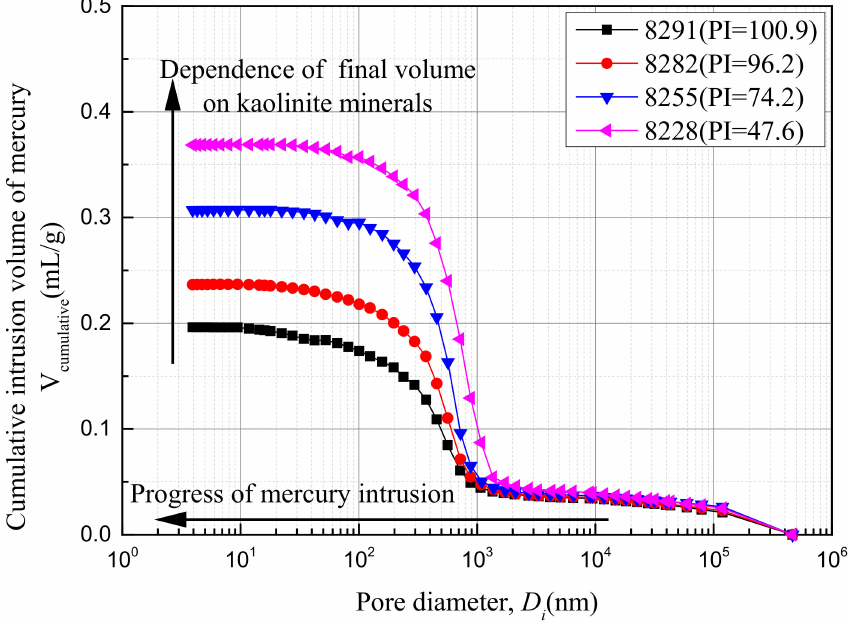
Figure 17. Pore-size distribution with respect to cumulative intrusion volume of mercury.